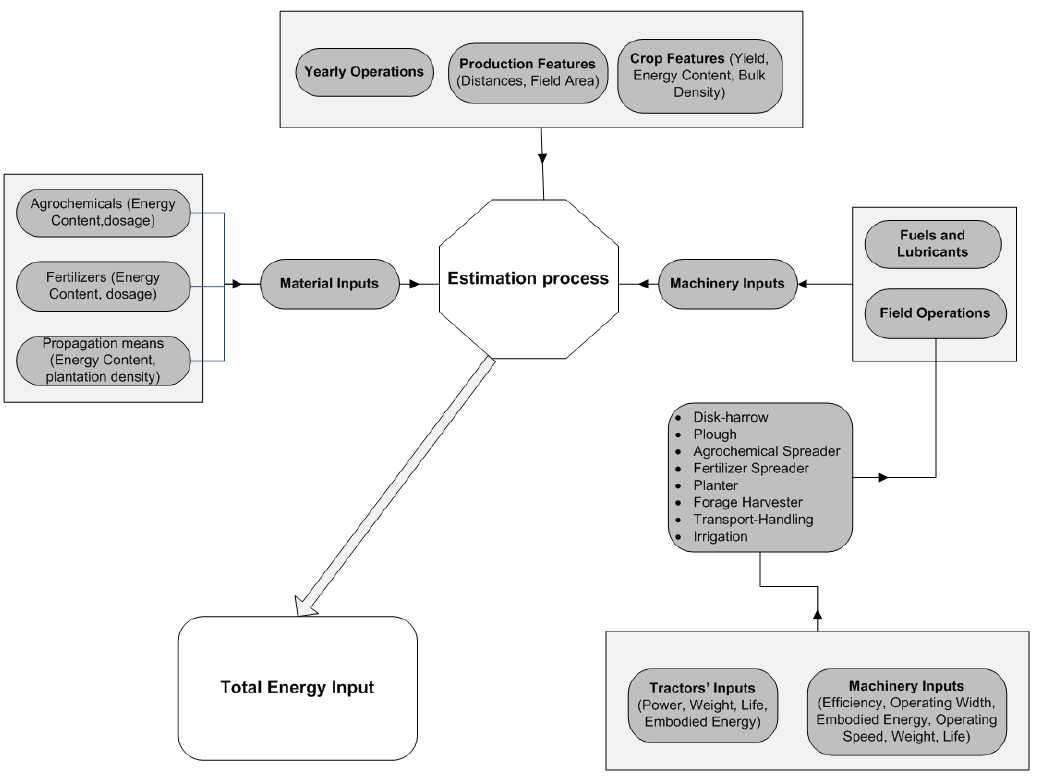
Figure 2. The general inputs for the input energy estimation process.